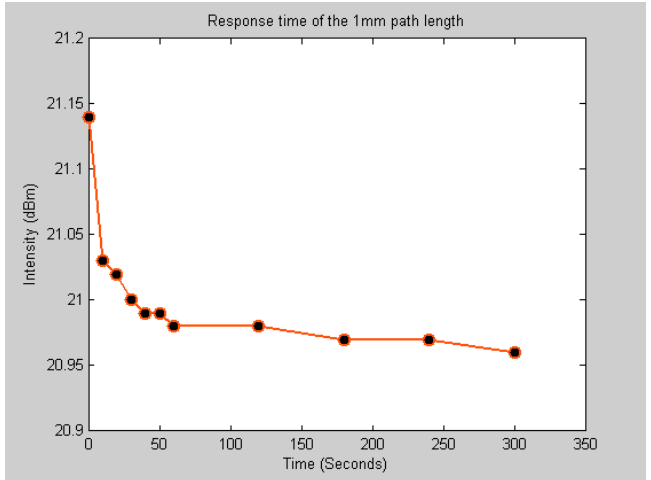
Figure 10. 1mm Path Length (25 µm bore size) Response